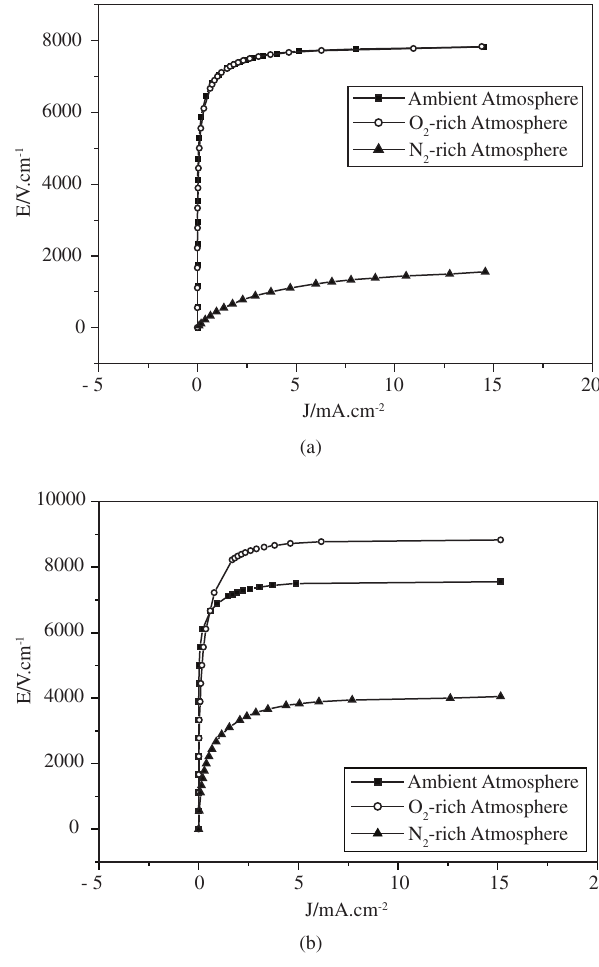
Figure 3. I�fl�e�ces of thermal treatme�t at 900 °C i� c�rre�t-te�sio� feat�res of two disti�ct S�O .CoO-�ased �olycrystalli�e 2